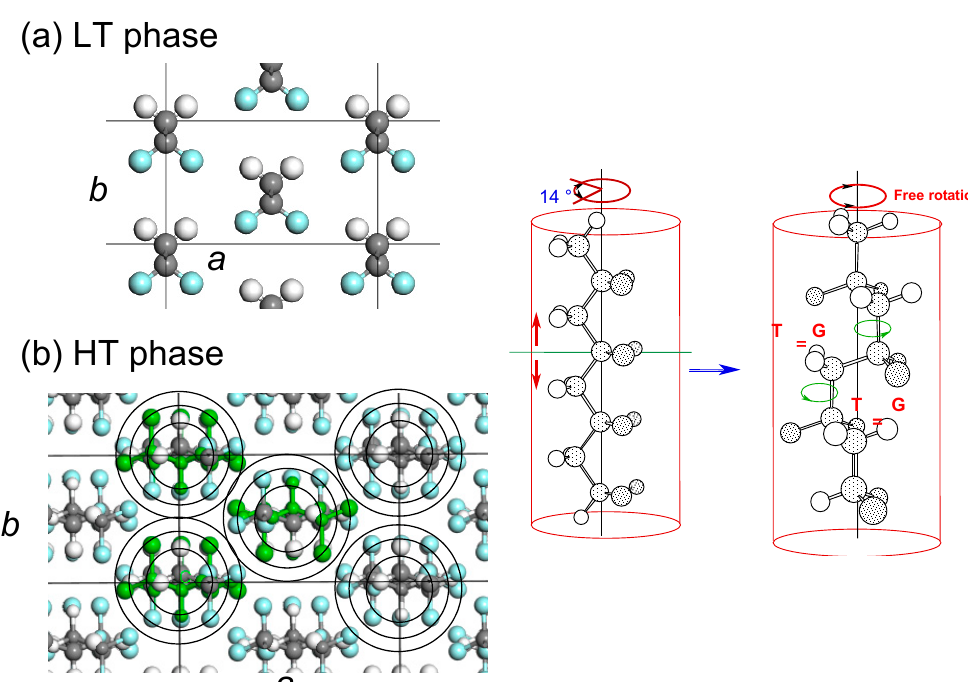
Figure 15. Crystal structure and chain conformation of the VDF–TrFE copolymer: ( a ) low-temperature phase and ( b ) high-temperature phase. The unit cell parameters were a = 9.11 Å, b = 5.25 Å, c = 2.55 Å for the LT phase and a = 9.75 Å, b = 5.63 Å, and c = 9.20 Å for the HT phase (VDF 55%) [43].